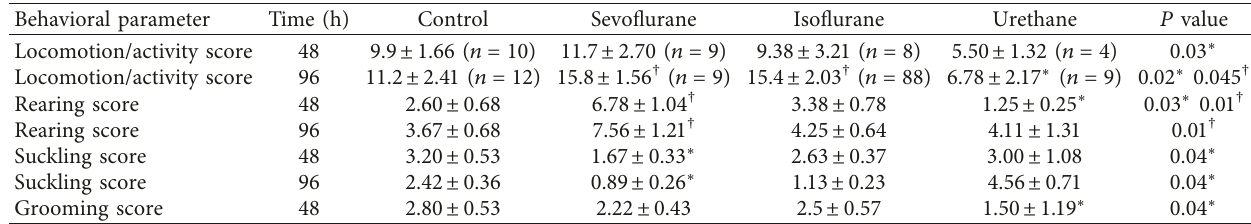
Table 1: Behavioral parameters of neonatal rats exposed to the anesthetic agents sevoflurane and isoflurane at 1 MAC for 4 h on postnatal day 15 and sacrificed 48 or 96h